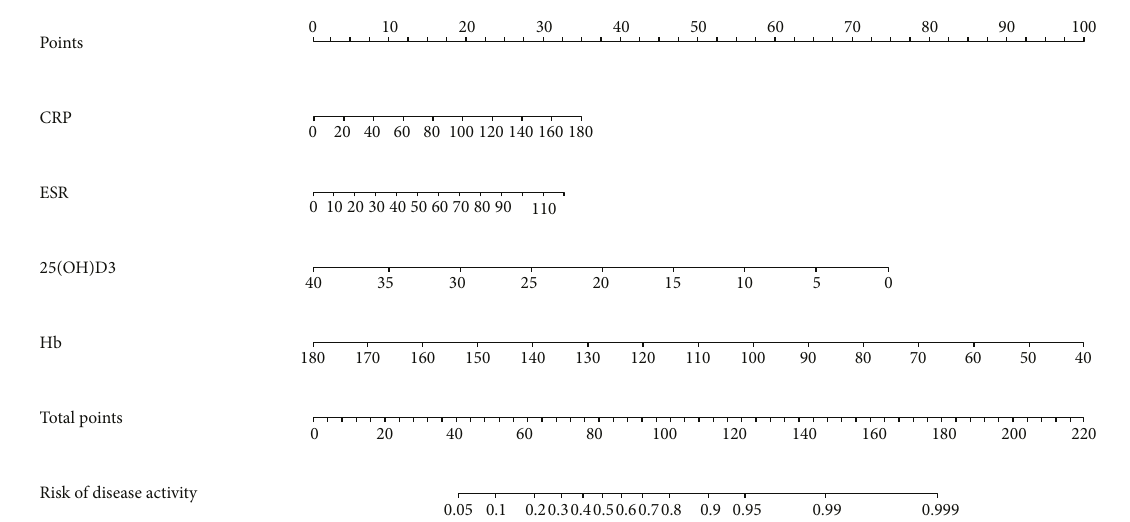
Figure 2: Nomogram for predicting active CD based on 25(OH)D3 and other serum parameters. The c-index of this nomogram was 0.882 with a sensitivity of 73.2% and a speci fi city of